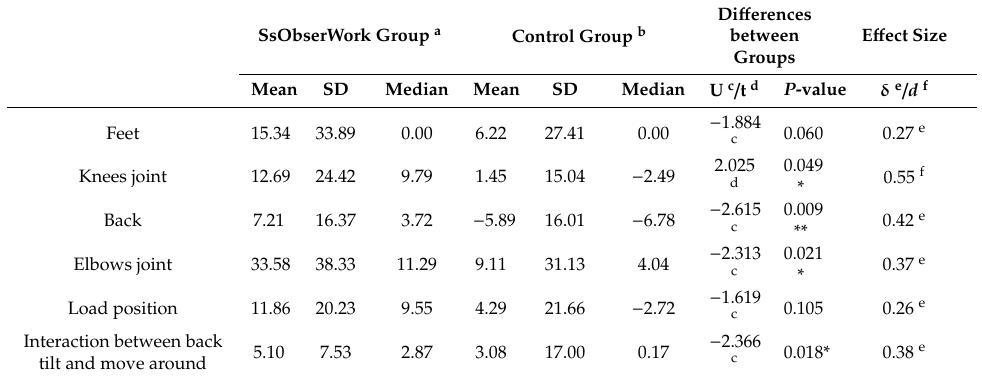
Table 3. Mean and standard deviation of score change (pre-post) of the relative duration in which each criterion was in the recommended position by the SsObserWork and control group, and di ff erences between